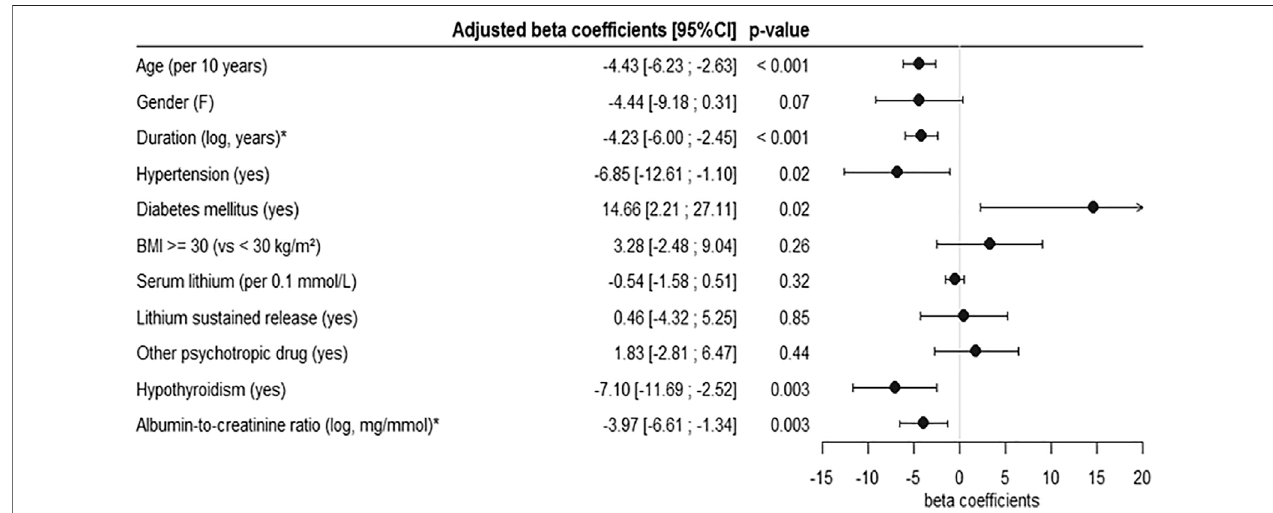
FIGURE2| MultivariableanalysisofthedeterminantsofmGFR. Determinants wereassessed usingmultivariablelinearregressionmodel,withmultipleimputations for missingdata.All thevariables included inthe modelarerepresented ontheforestplot. F: female, BMI: bodymassindex, mGFR: measured glomerular fi ltration rate. * The indicated coef fi cients correspond to a 2.72-fold [ (cid:1) exp (1)] increase in lithium treatment duration or in albumin-to-creatinin ratio.